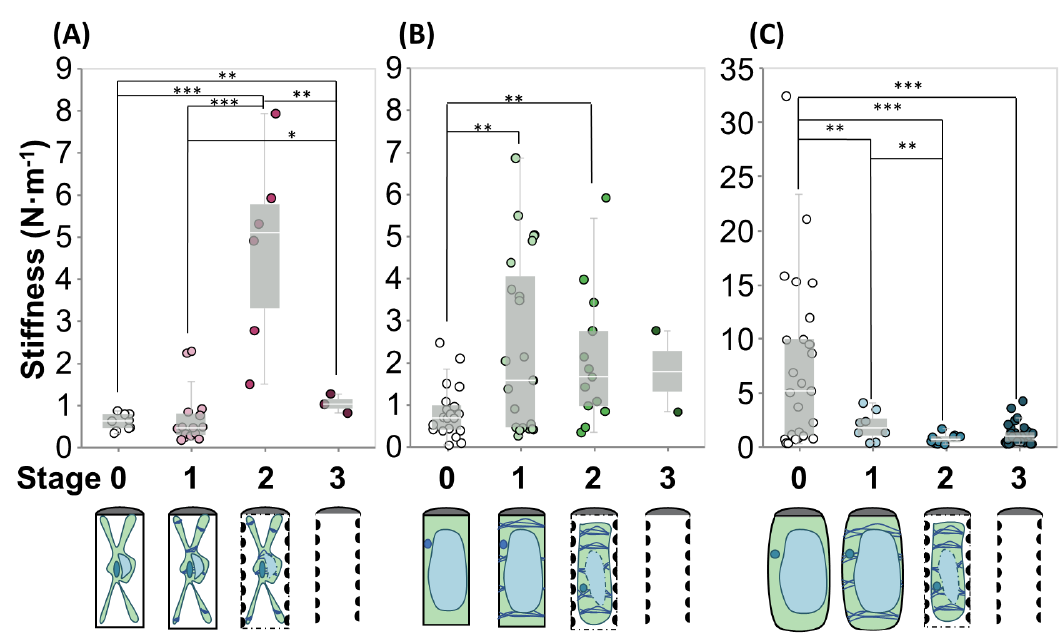
Figure 4. Panel showing the stiffness in 4 stages of transdifferentation in 3 types of solutions with different osmolarity: ( A ) sorbitol; ( B ) growth medium; ( C ) water. Note the difference in scale on the y-axis in ( C ) from the extreme stiffness of cells in hypotonic conditions before induction of differentiation. Bottom line graphically represents the morphology of the cells in each condition and stage. Stars indicate significant differences in distribution according to the nonparametric Kolmogorov-Smirnov test. * p < 0.1, ** p < 0.05, *** p < 0.01. (Data shown correspond to 2 < n < 35. Each indentation test on an individual cell is represented by a point in the